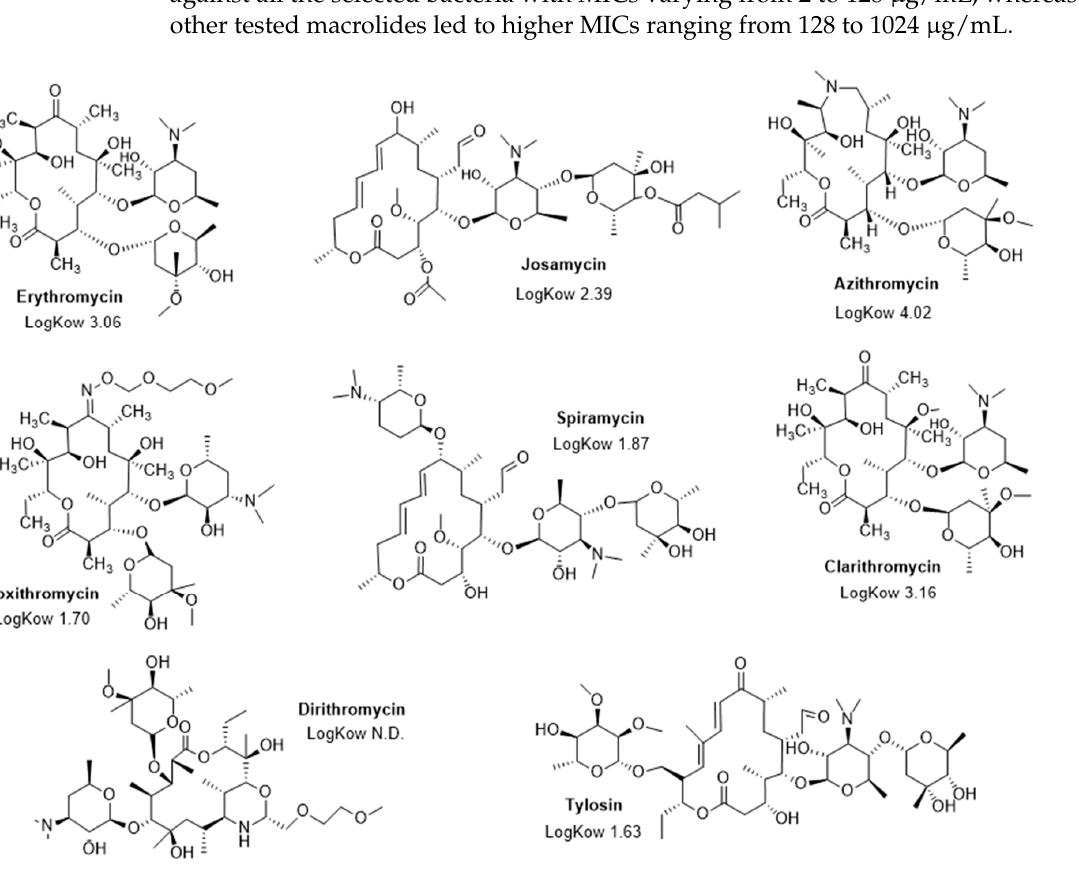
Table 3. Minimum Inhibitory Concentrations of macrolides against various Gram ‐ negative bacteria.